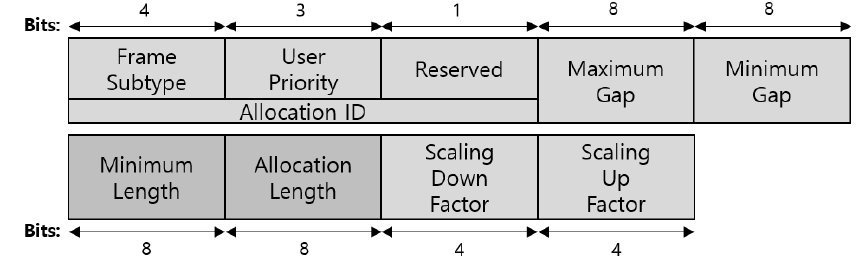
Figure 9. IEEE 802.15.6 MAC frame format and connection request frame format.